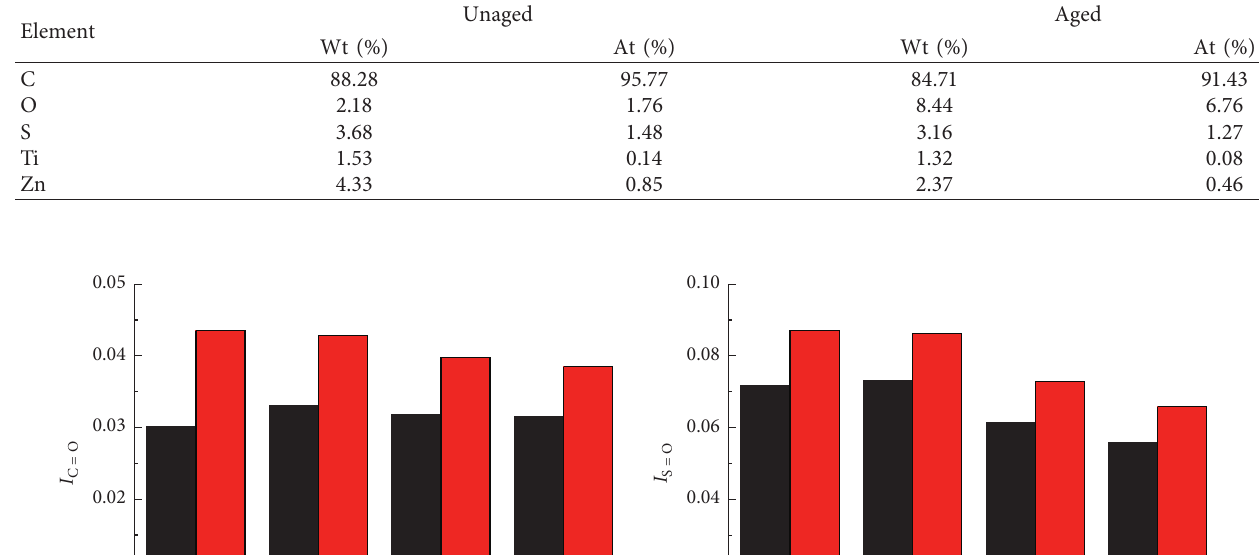
Table 9: EDS test results of nano-ZnO/nano-TiO 2 /copolymers SBS-modified asphalt before and after UV ageing. Unaged Aged Element Wt (%) At (%) At (%)